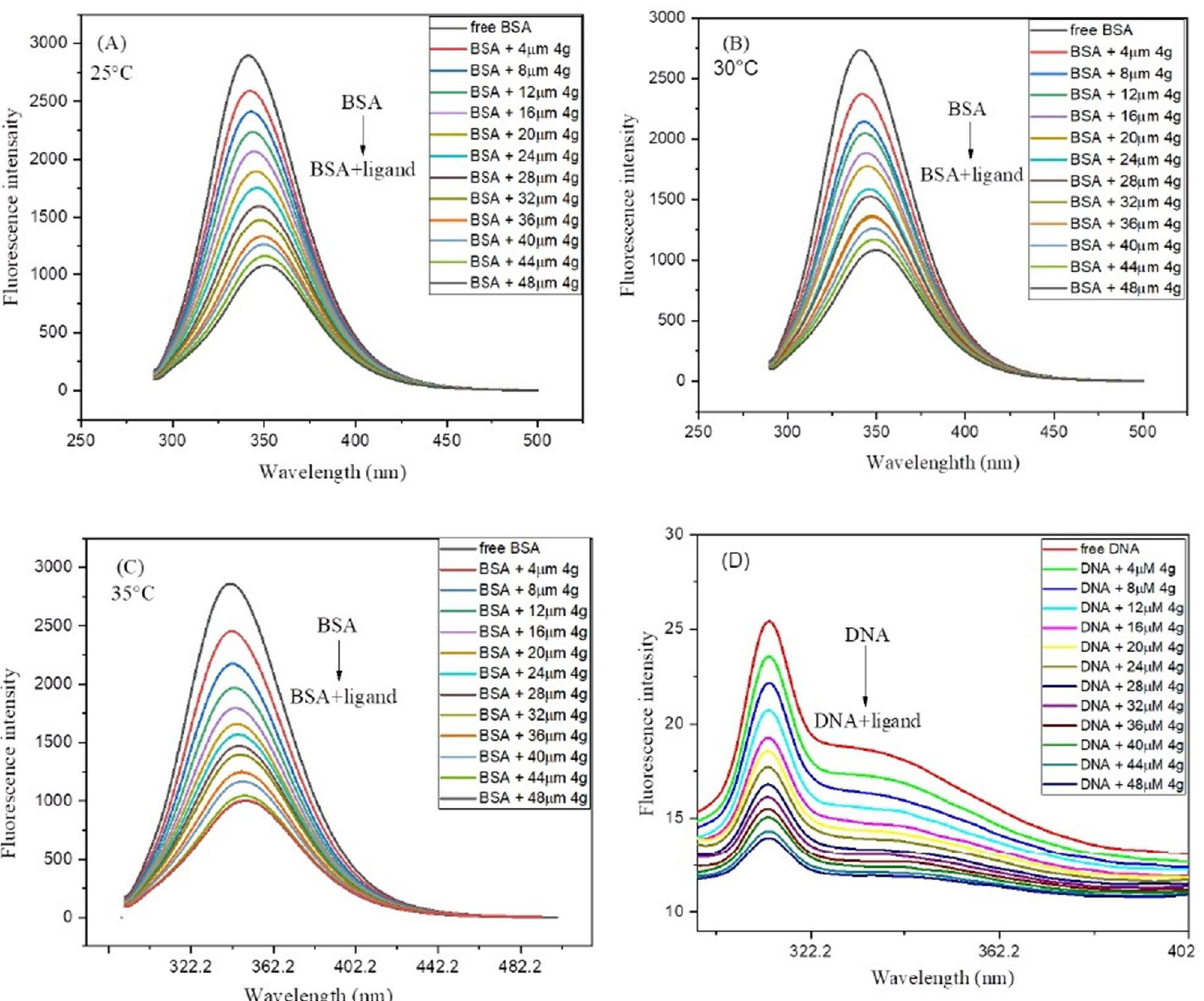
Figure 10. Fluorescence spectra of pure DNA/BSA and DNA/BSA- 4g complex at a variable concentration of 4g (0–48 µM) ( A ) BSA spectra at 25 °C; ( B ) BSA spectra at 30 °C; ( C ) BSA spectra at 35 °C; ( D ) DNA spectra at 25